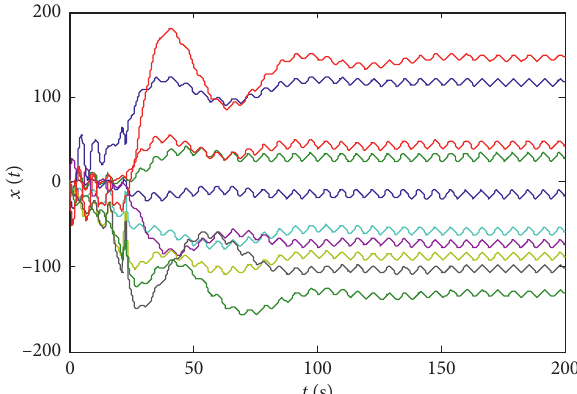
Figure 1: The state response curves of the nodes subsystem.